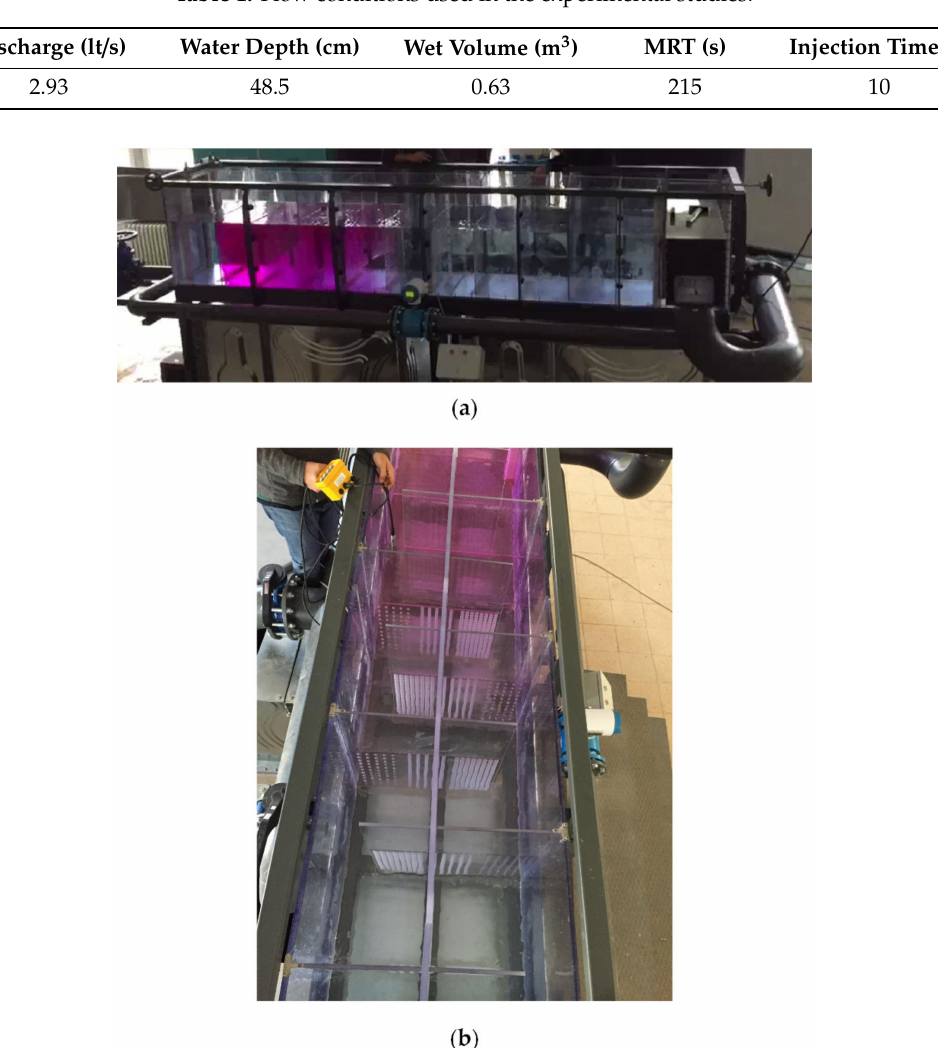
Figure 3. Snapshot of the experimental setup during tracer studies in the laboratory: ( a ) front view; ( b ) plan